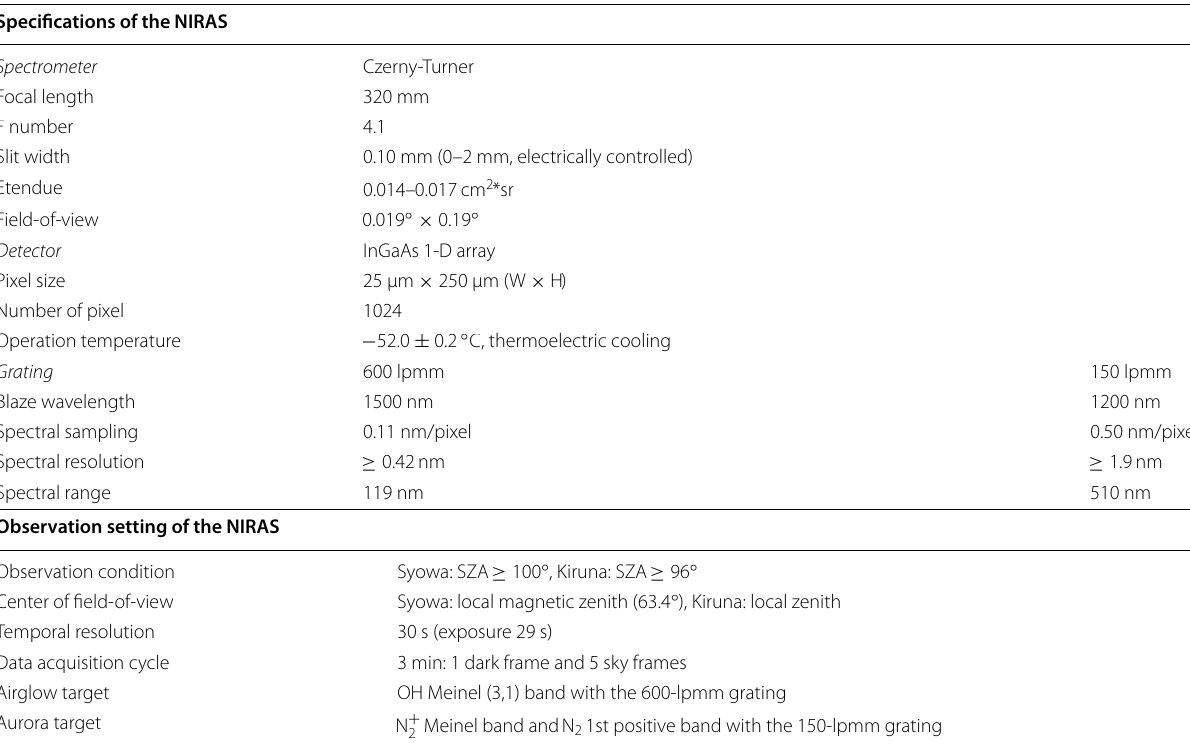
Table 2 Key properties of the NIRAS, both the spectrometer and the detector are manufactured by HORIBA Scientific. Typical operational parameters are also